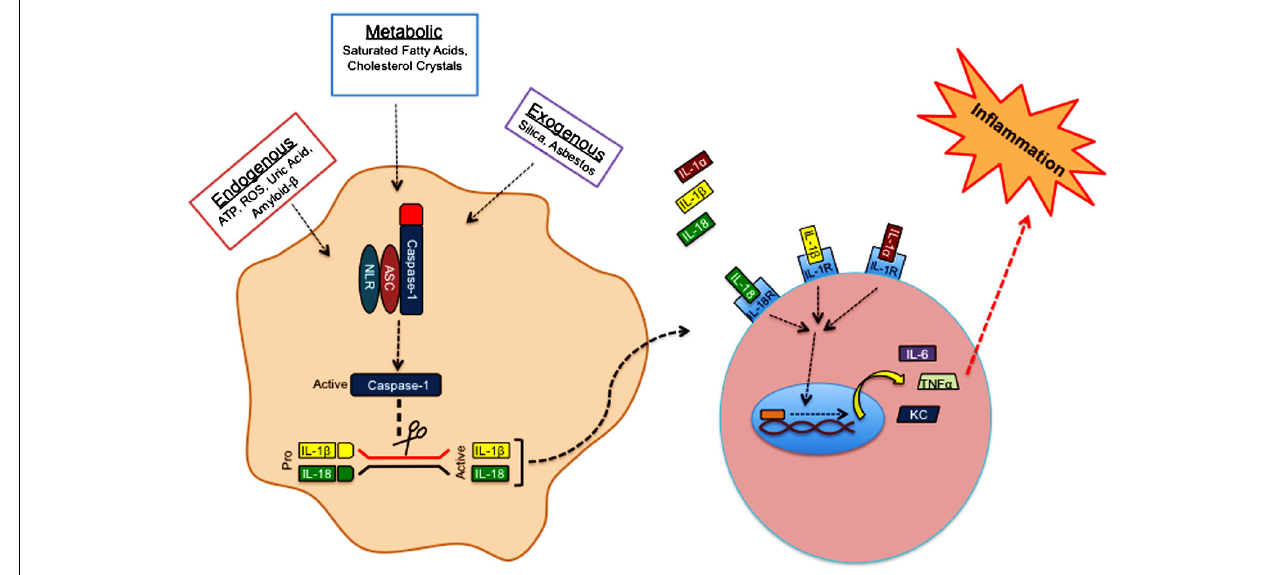
cleaves the pro-forms of IL-1 β and IL-18, which is required for their secretion and biological activity. Inflammasome-derived IL-1 β , and IL-1 α that is released from dying cells bind IL-1R, whereas IL-18 has its own receptor. Engagement of IL-1R or IL-18R promotes the robust production of secondary proinflammatory molecules (TNF α , IL-6, KC, etc.) that can then trigger additional immune cell recruitment and activation.